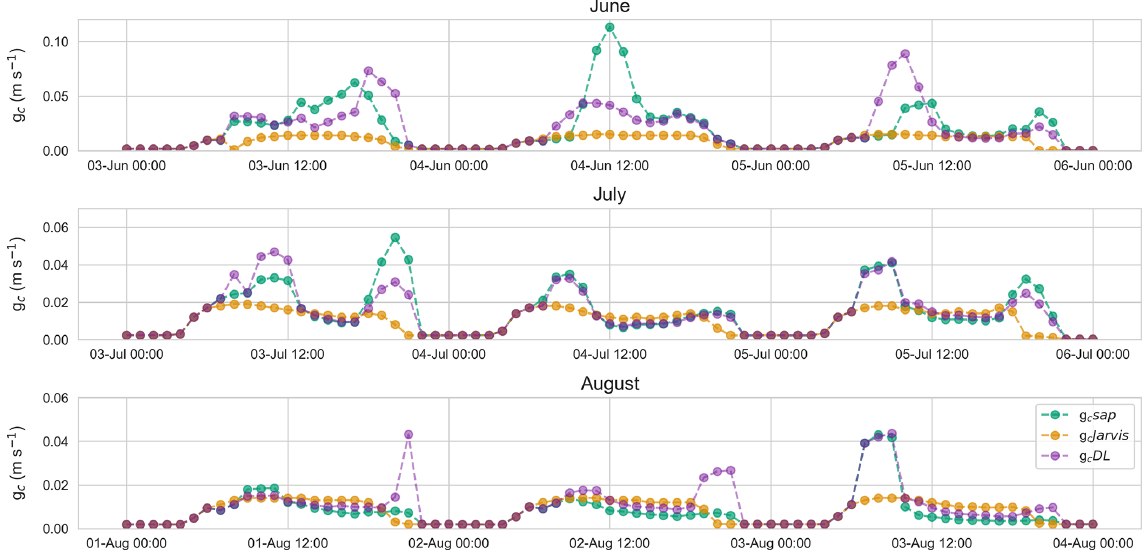
Figure 5. Hourly canopy conductances of g c sap (green), g c Jarvis (orange), and g c DL (purple) for 3 selected days in June, July, and August during the growing season